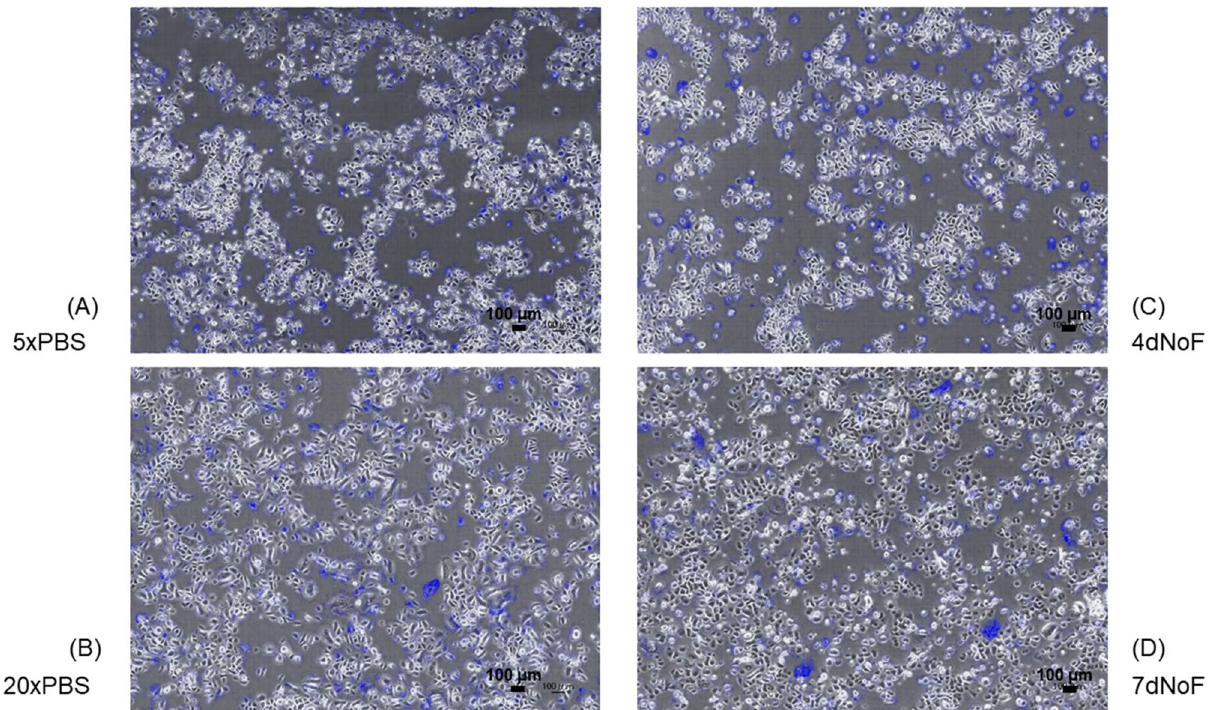
Figure 4. Cellular images having displacement vectors cultured under four different metabolic challenge protocols. Representative images (first frame) of cells in four different metabolic challenges with displacement vectors from MS calculation using OF algorithm. ( A ) 5×PBS, ( B ) 20×PBS, ( C ) 4dNoF, ( D ) 7dNoF. The original video files are provided in Supplementary Videos